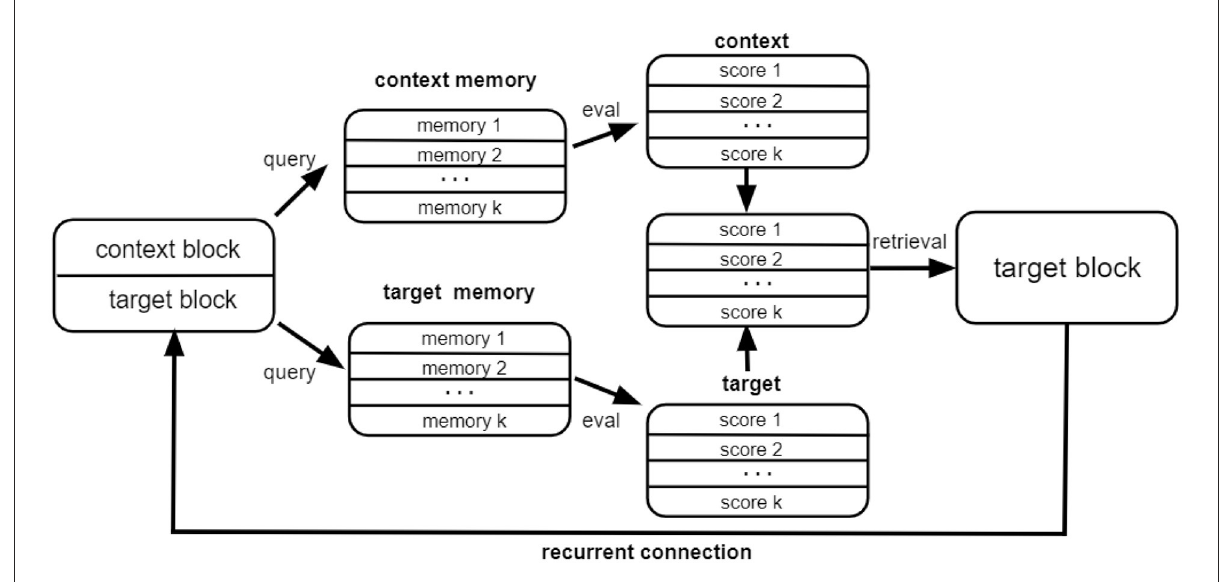
FIGURE2 The architecture of our network within each